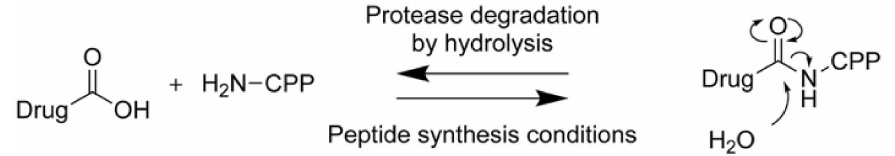
Scheme 1. Representation of general amide bond formation and possible cleavage by prote- olytic